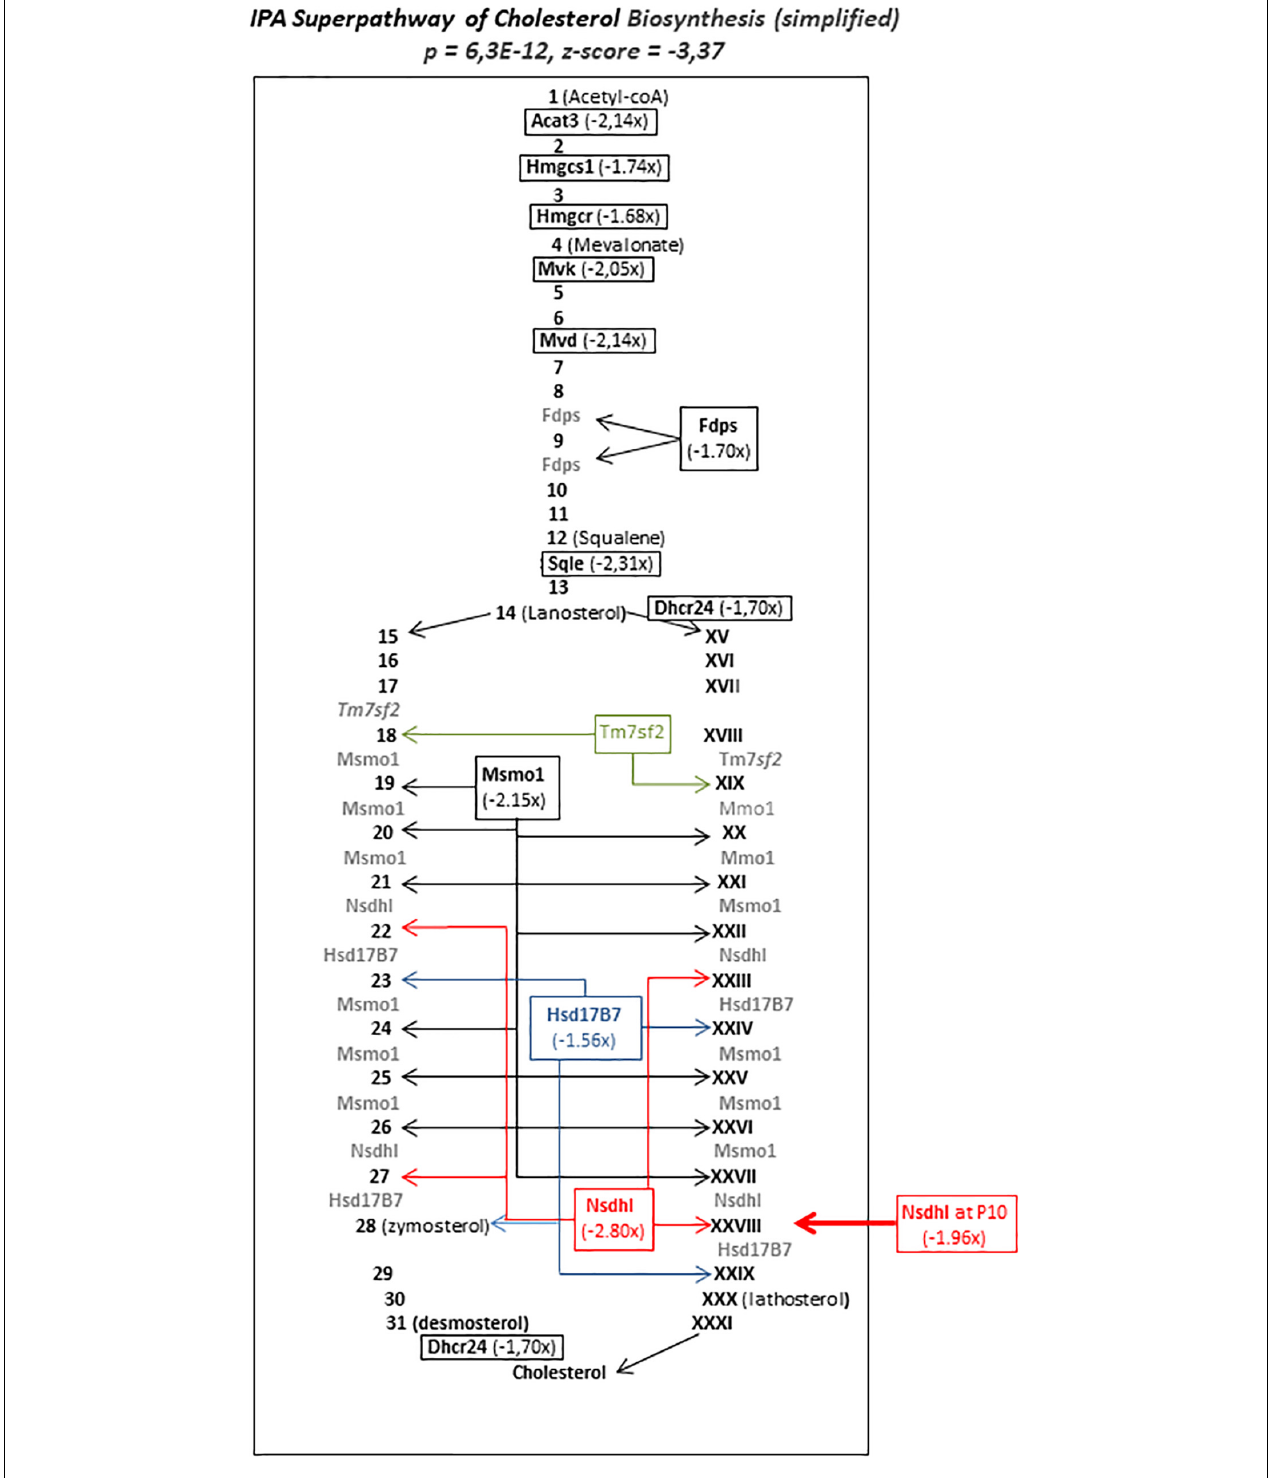
FIGURE 7 | Simplified schematic representation of seIPA-path “super pathway of cholesterol biosynthesis” significantly repressed in P5 brain 12 h after HI ( p = 6.3E-12, z -score = –3.37). Repressed genes figure in bold characters. Numbers (Arabic and roman) figure intermediate metabolites in two alternate biosynthesis routes. Values in parentheses indicate fold change inhibition at 12 h after HI. Acat3 enzyme coding gene (in bold italics) does not exist in Human, thus IPA § release proposed the human homolog Acat2. Arrows indicate the enzyme’s multiple sites of implication. Large Arrow pointed toward Nsdhl, the only gene in this pathway affected by HI at